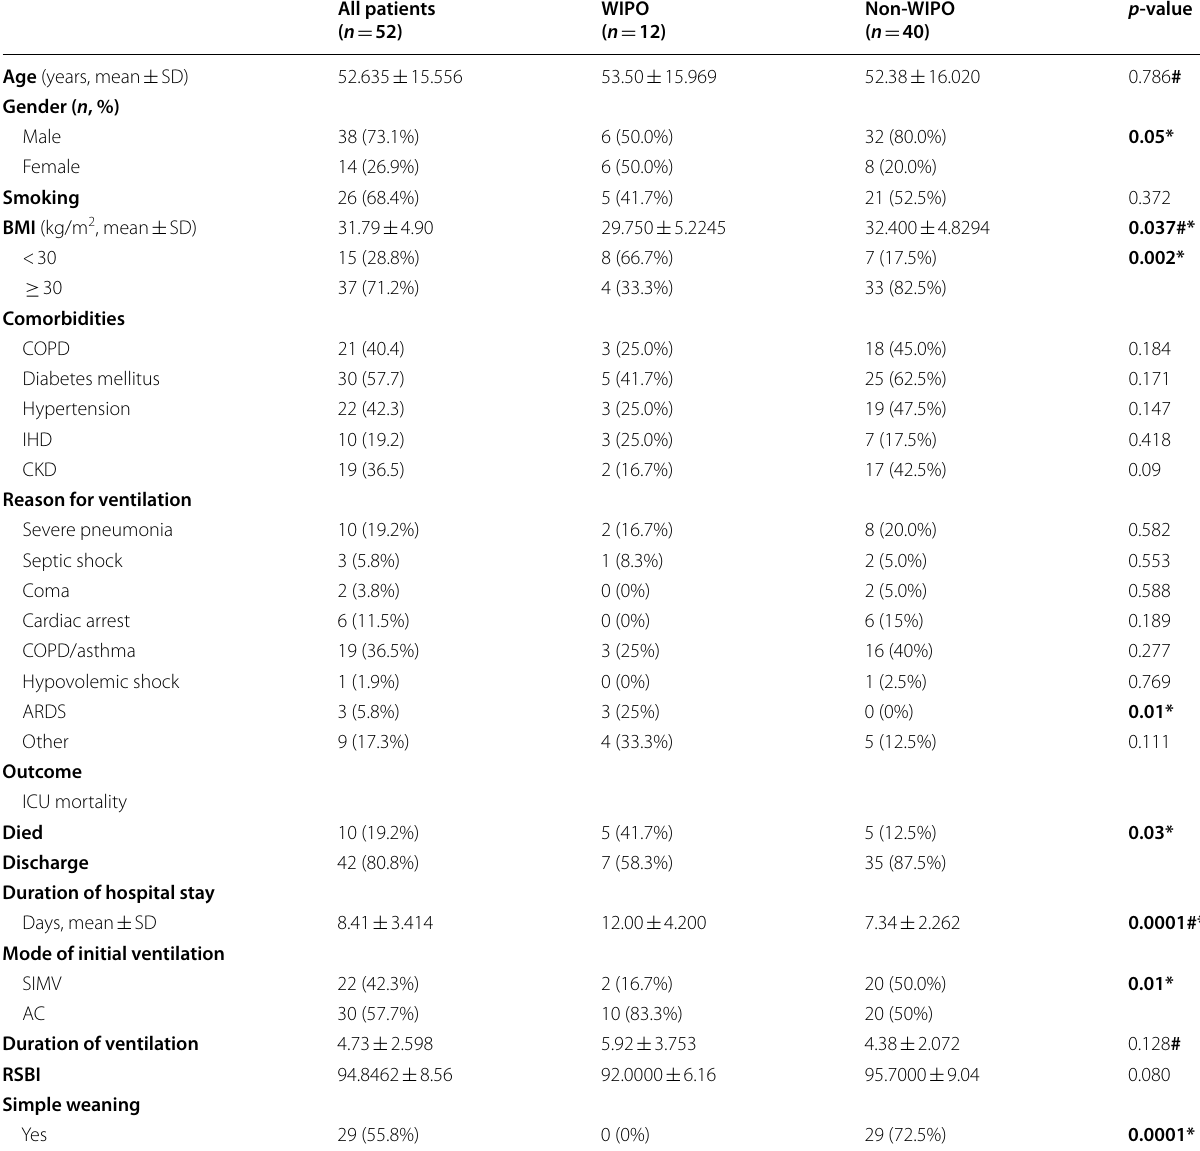
Table 1 Clinical characteristics of studied